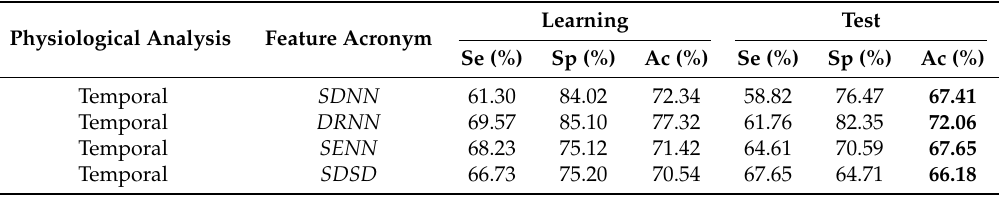
Figure 3. Receiver operating characteristic (ROC) curves for the four statistical significant parameters: ( a ) SDNN (standard deviation of NN intervals), ( b ) DRNN (dynamic range of NN intervals), ( c ) SENN (standard error of successive differences of adjacent NN intervals), ( d ) SDFD (the first derivative of standard deviation). AUC: area under curve. Table 3. Sensitivity (Se), specificity (Sp) and accuracy (Ac) of significant parameters using ROC (receiver operating characteristic) analysis for training and test subsets.